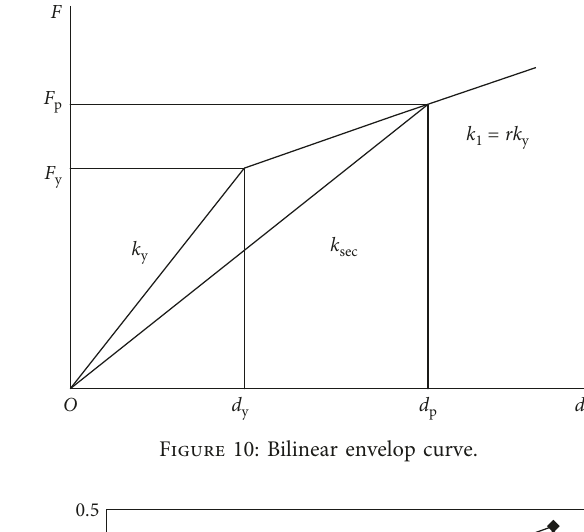
Figure 10: Bilinear envelop curve.